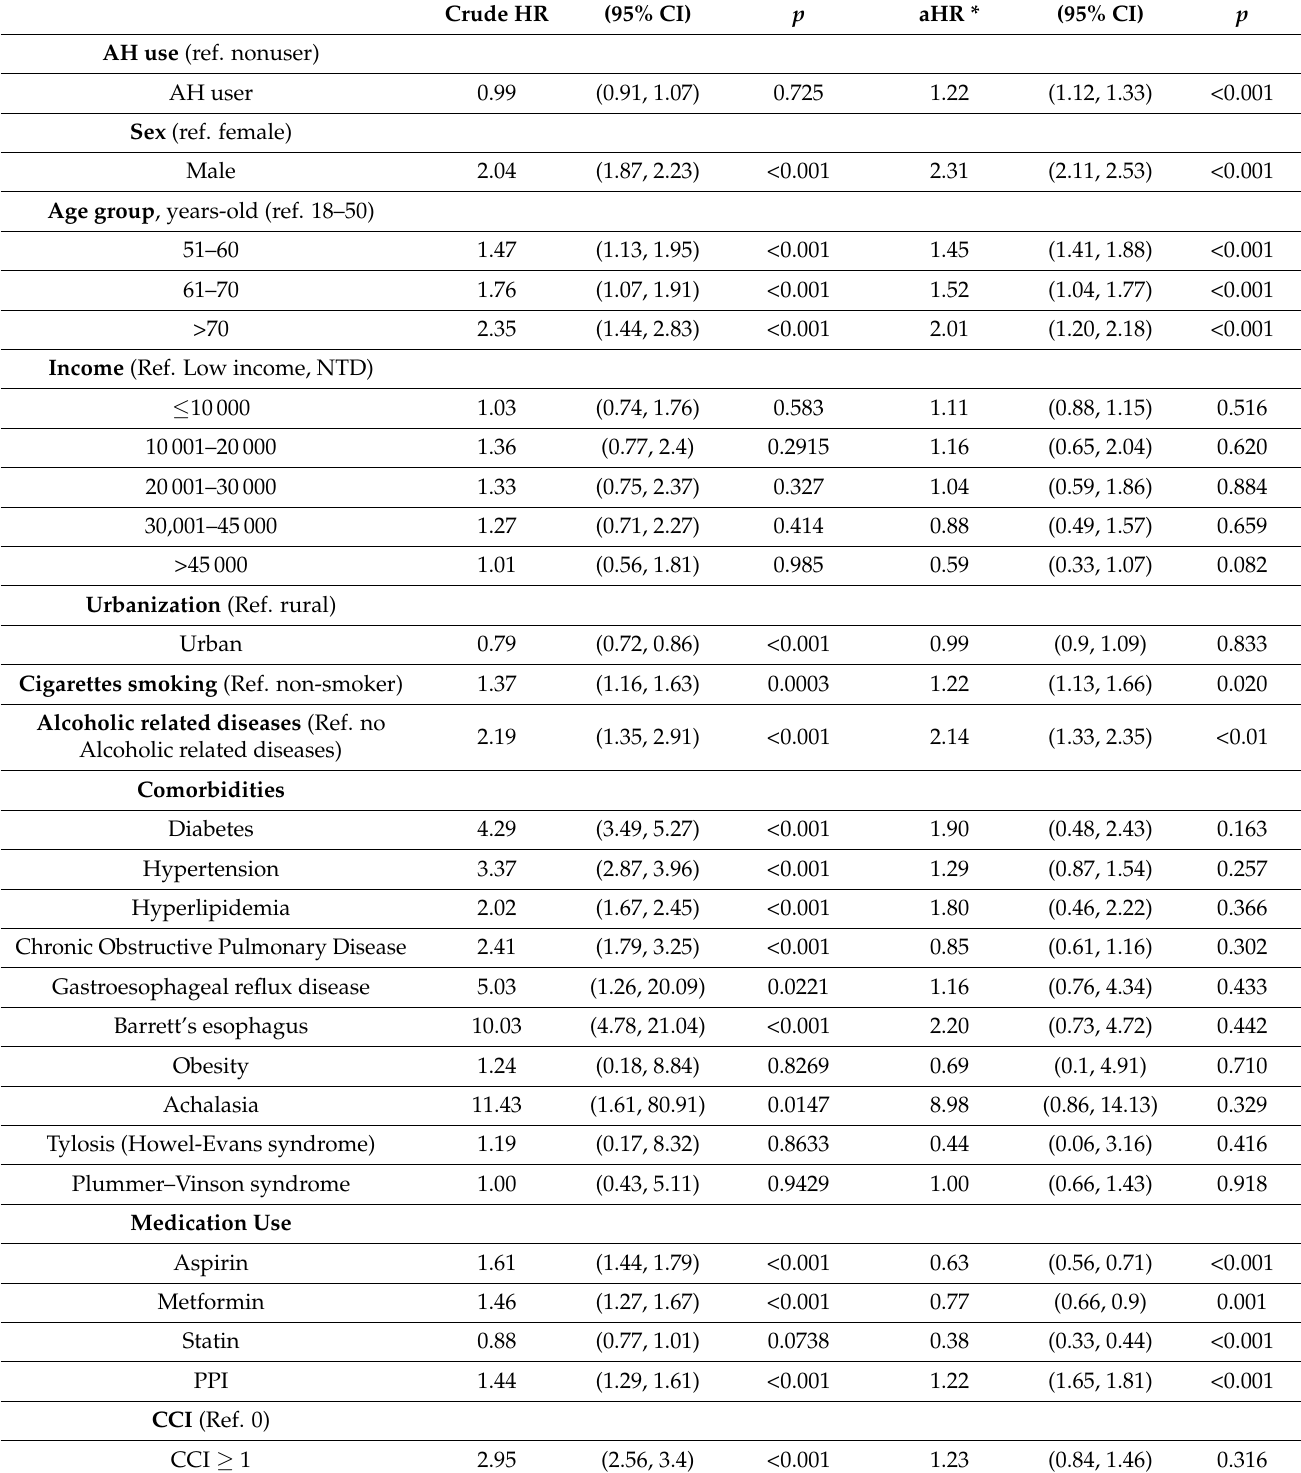
Table 2. Association of Comorbidities and Concurrent Medications with ESCC